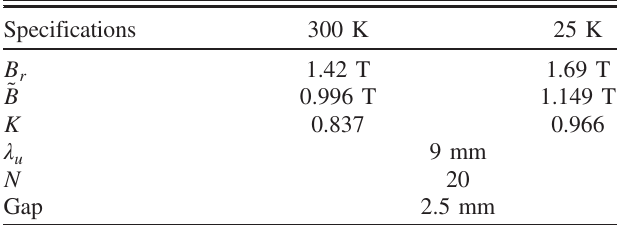
FIG. 1. On-axis photon flux density of UR, according to Eq. (5), normalized to the measured K parameter at RT. Theory predicts a relative gain in photon flux density of 9%, 66%, and 100% for the 1st, 3rd, and 5th harmonic, respectively, if K is increased from 0.837 at RT to 0.966 at 29 K.